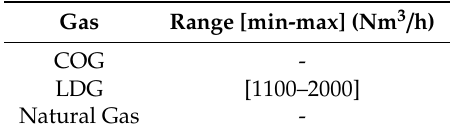
Table 6. Consumption ranges of the electric